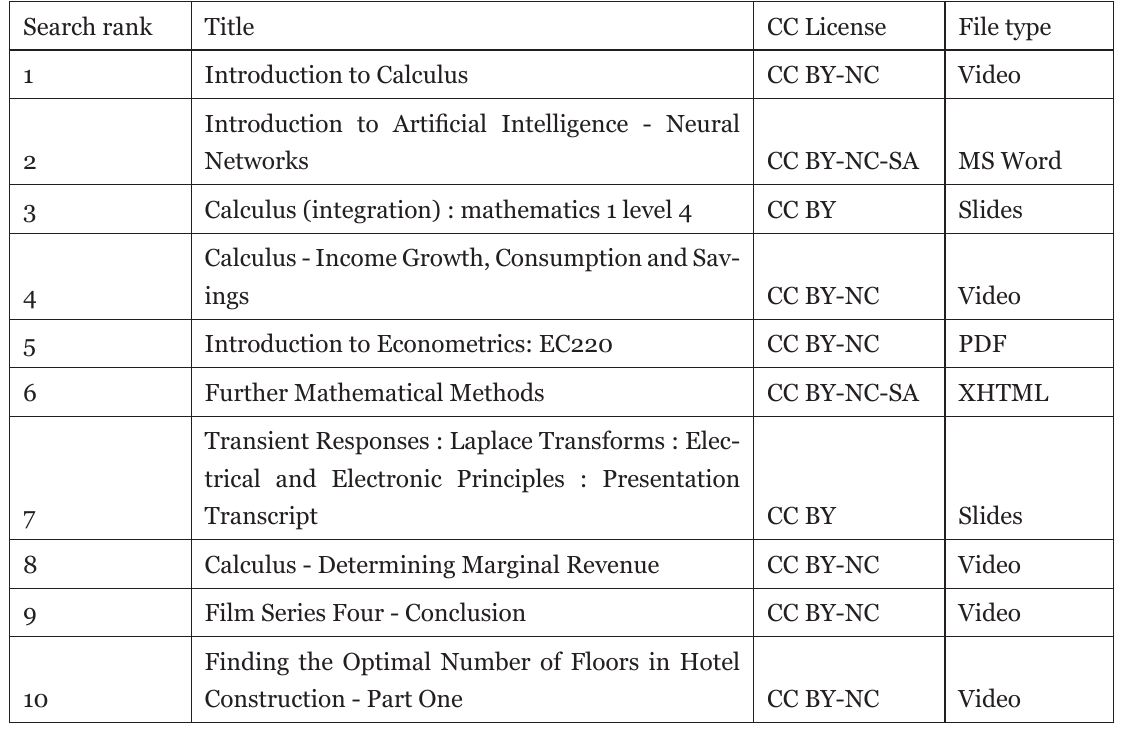
Top Ten Search Results Returned by JORUM for the Keyword Calculus Search